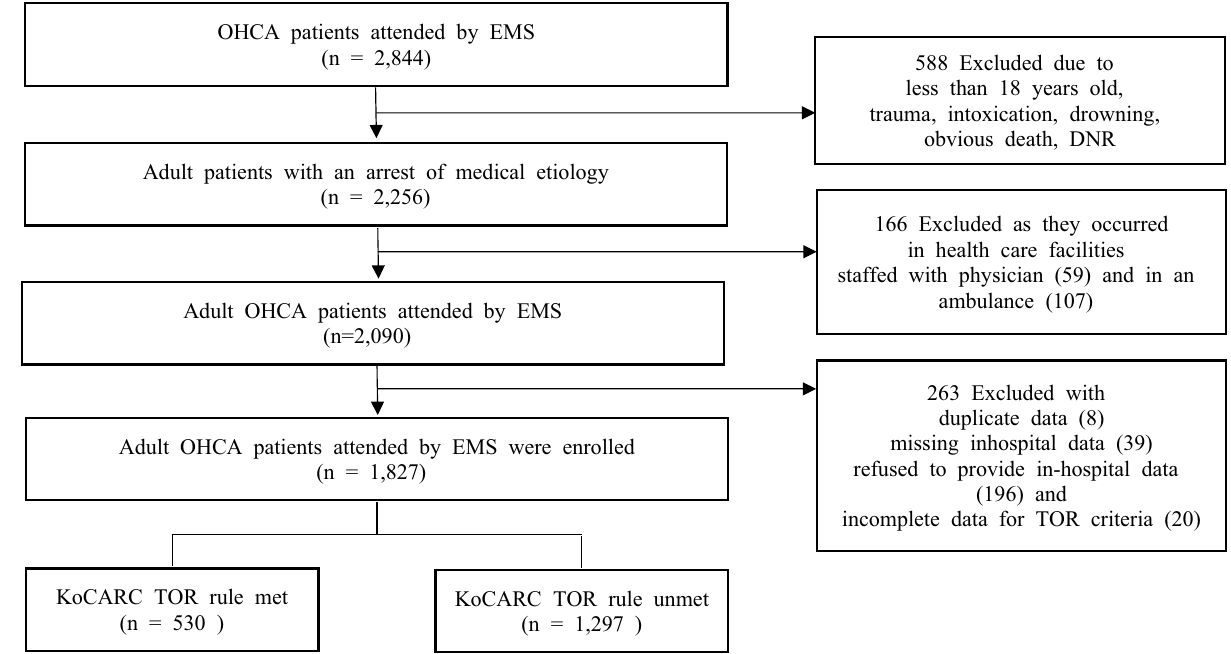
Figure 1. Definition of the study cohort. OHCA, out-of-hospital cardiac arrest; EMS, emergency medical service; KoCARC, Korean Cardiac Arrest Research Consortium; TOR, termination of resuscitation; DNR, do not